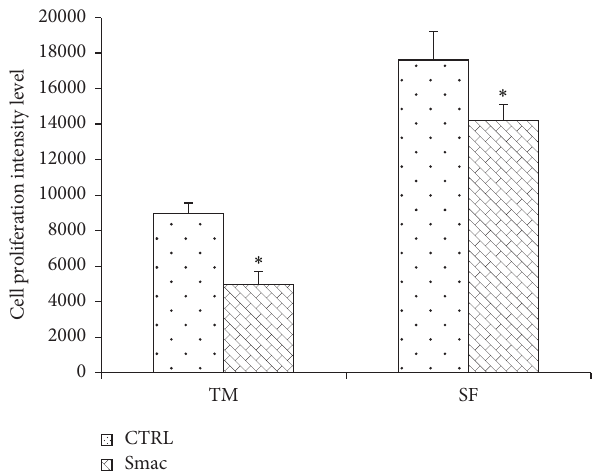
Figure 2: Smac127 inhibits the proliferation in fibroblast-like synoviocytes (FLSs) derived from patients with rheumatoid arthritis (RA). RA-FLSs were cultured in tissue medium alone (TM) or in synovial fluid (SF). CTRL are the cells without Smac127. “Smac” are the cells after the addition of Smac127 (15 𝜇 M) for 24 hrs. The data are generated with Odyssey infrared platform. In Cell Western with 700 channels detecting cell proliferation, we detected cytokine production with 800 channels. Results are expressed as the mean percentage ± SD from four individual experiments. ∗ 𝑝 < 0.05 versus CTRL or SF.